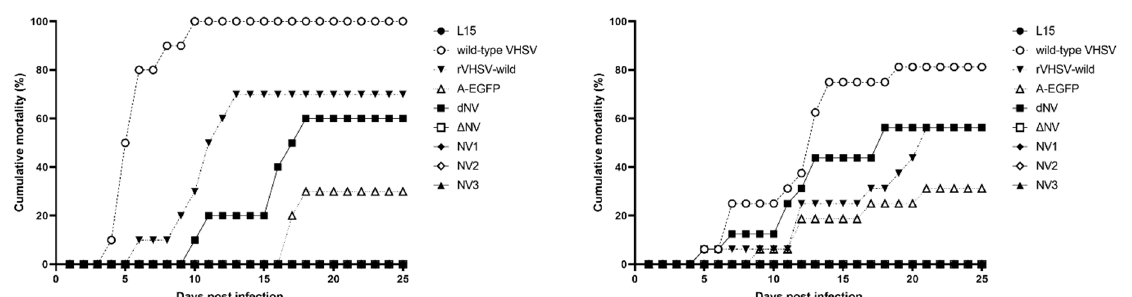
Figure 5. Cumulative mortality rates of olive flounder fingerlings challenged with wild-type VHSV, rVHSV-wild, rVHSV-A-EGFP (A-EGFP), rVHSV-dNV (dNV), rVHSV- ∆ NV ( ∆ NV), rVHSV-NV1 (NV1), rVHSV-NV2 (NV2), or rVHSV-NV3 (NV3) at 10 3 PFU per fish (2 replicates). We recorded the cumulative mortality rates daily for 25 days post-injection.